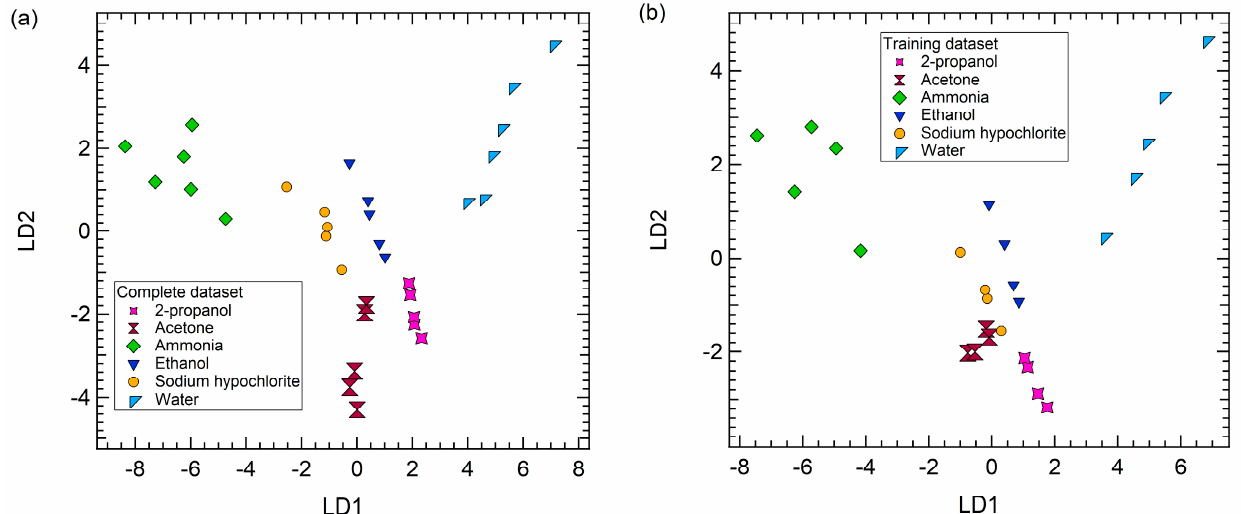
Figure 6. ( a ) The LDA space of the sensor array responses to ammonia, water, acetone, ethanol, and 2 ‐ propanol concentrations, performed considering the complete dataset (i.e., 32 exposures). ( b ) Example of the LDA space of the sensor array responses to ammonia, water, acetone, ethanol, and 2 ‐ propanol concentrations, performed considering a training dataset containing 26 exposures.